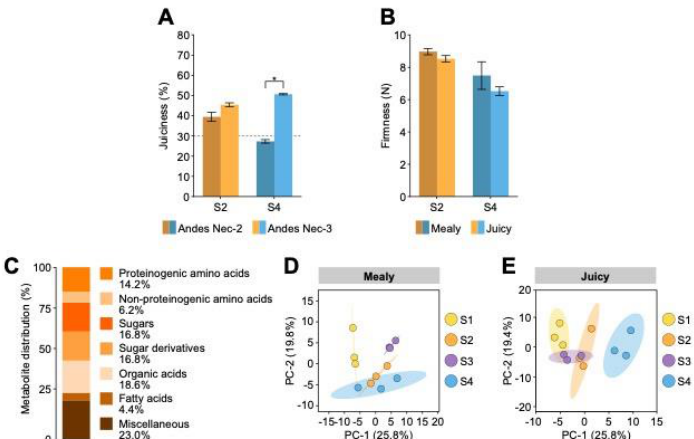
Figure 1. Nectarine phenotyping and global metabolite analysis. ( A ) Juiciness percentage in ripe fruits from Andes Nec − 2 and Andes Nec − 3 varieties. ( B ) The firmness of ripe fruits from the mealy and juicy varieties. Error bars represent SEM ( n = 9). Data were tested by t − test (* p < 0.05). ( C ) Distribution of identified metabolites by GC − MS. Principal Component Analysis (PCA) of metabolites from S1, S2, S3, and S4 stages. Score plots of the mealy metabolite dataset ( D ) and the juicy metabolite dataset ( E ) consisting of three biological replicates ( n = 3).